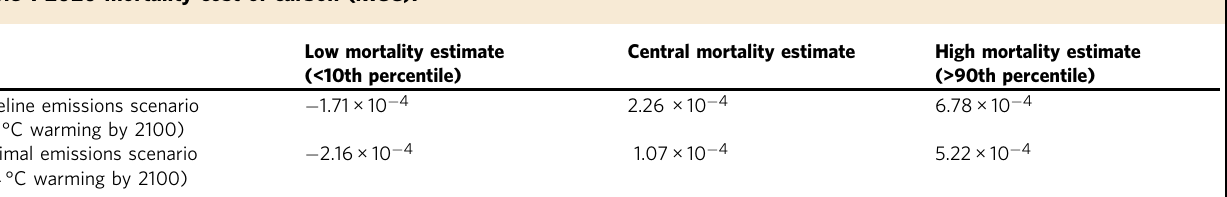
Table 1 2020 mortality cost of carbon